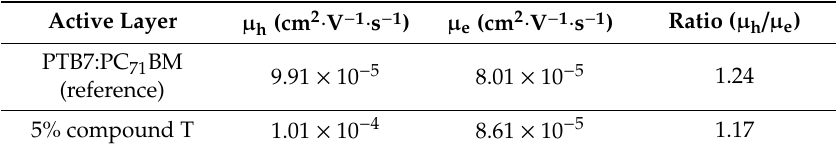
* The data were averaged from ten identical OSC devices with six cells